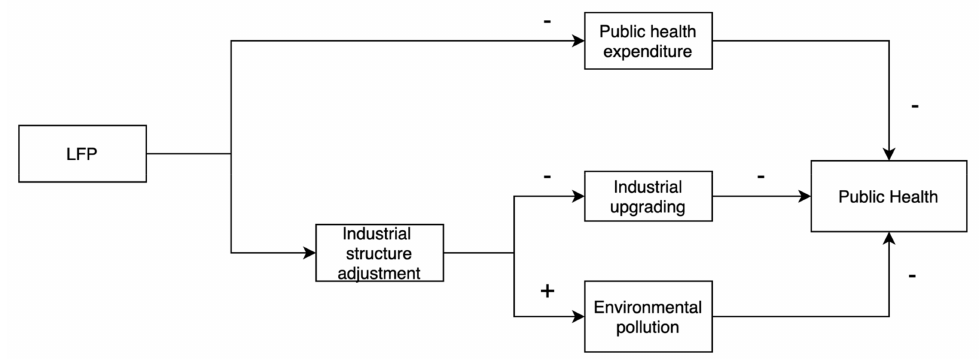
Figure 1. Mechanism flowchart of the impact of LFP on public